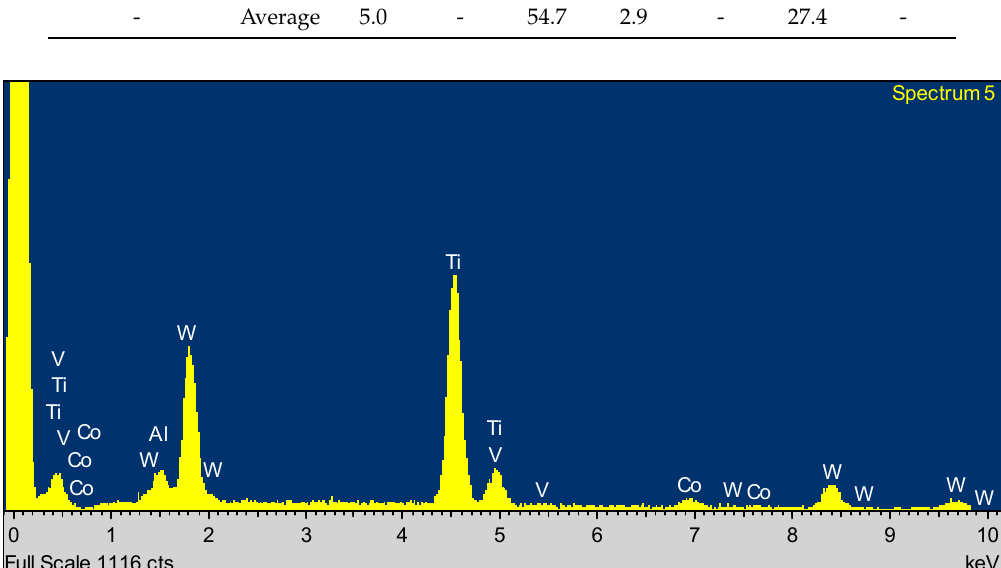
Figure 6. EDS spectrum of edges of a WC tool cutting Ti with Boelube+2%MoS 2. Table 4. Elemental analysis of surface of the edge of a WC tool cutting Ti with Boelube+2%MoS 2 . WC Tool (with Boelube+2%MoS 2 ) (all Results in Weight %) Spectrum In stats.